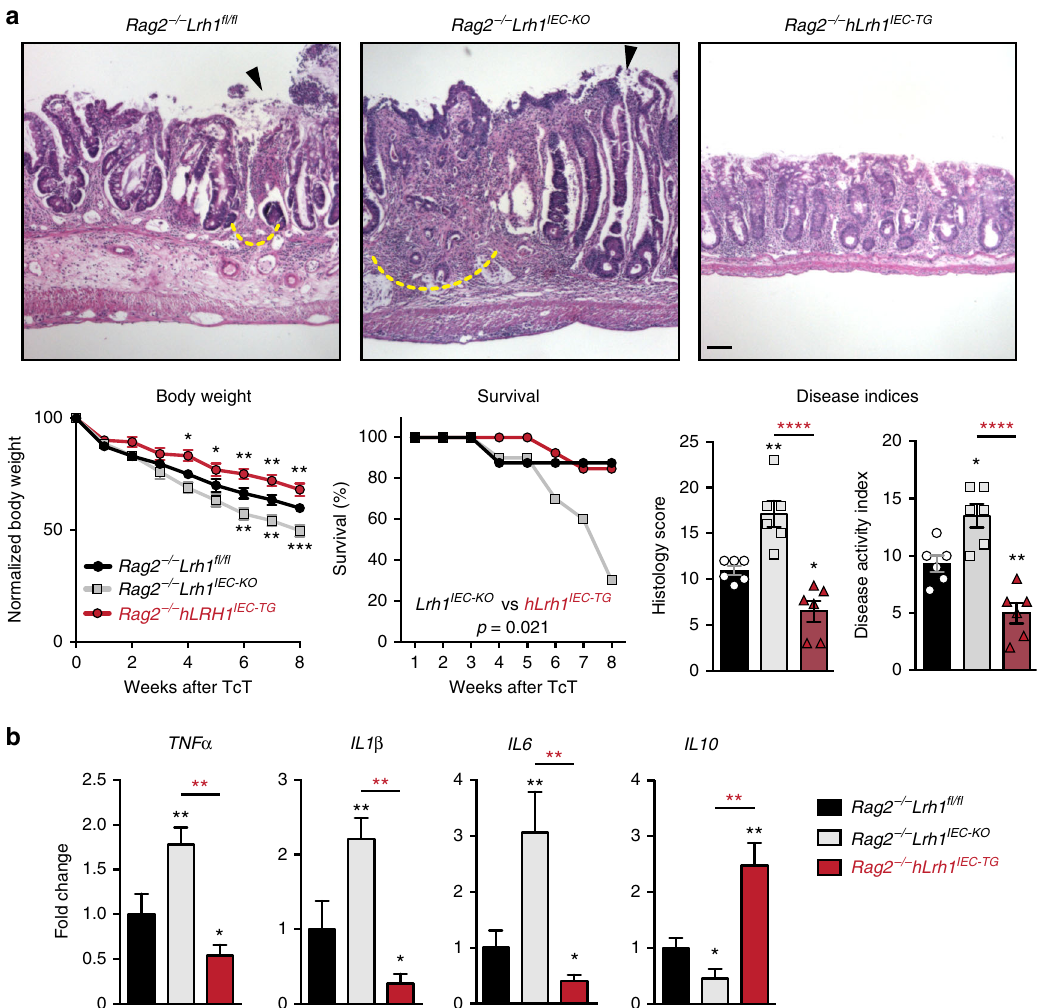
Fig. 5 hLRH-1 overexpression decreases disease severity in T-cell transfer colitis. a Representative histology from T-cell transfer colitis model for Rag2 − / − Lrh1 fl / fl , Rag2 − / − Lrh1 IEC-KO , and the LRH-1 overexpressing mouse line Rag2 − / − Lrh1 IEC-TG . Areas of mucosal erosion indicated with black arrowhead, crypt destruction indicated with dashed yellow line. Animal weight loss, survival during disease course, histology scores, and disease activity index are plotted below. Animal weight loss was normalized to nondiseased control at each time point. Scale bar = 100 μ m. b Relative RNA levels of in fl ammatory and regulatory cytokines from colonic tissue of in fl amed colon. Black and red asterisk symbols indicate comparison with Rag2 − / − Lrh1 fl /f and Rag2 − / − Lrh1 IEC-TG groups, respectively. Survival curves were determined by Kaplan − Meier survival analysis and Log-rank test; error bars are SEM. Statistical analyses for normalized body weights determined by two-way ANOVA and for histology and disease activity index determined by one-way ANOVA with p values of * p = < 0.05, ** p = < 0.01, and **** p = < 0.0001. For weight analysis, n = Rag2 − / − Lrh1 fl / fl no TcT ( n = 4), Rag2 − / − Lrh1 IEC-KO ( n = 6), Rag2 − / − Lrh1 IEC-TG ( n = 6). For survival analysis, n = Rag2 − / − Lrh1 fl / fl ( n = 8), Rag2 − / − Lrh1 IEC-KO ( n = 10), Rag2 − / − Lrh1 IEC-TG ( n = 13). For